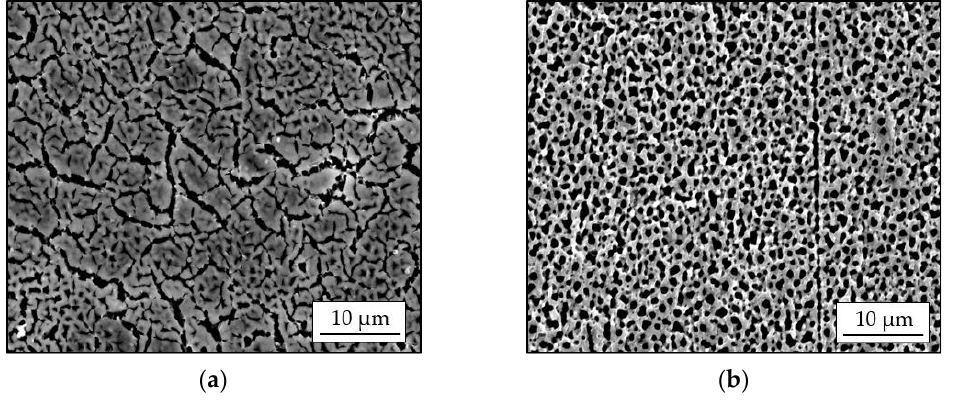
Figure 1. SEM images of samples: ( a ) PS; ( b ) CuO/PS.